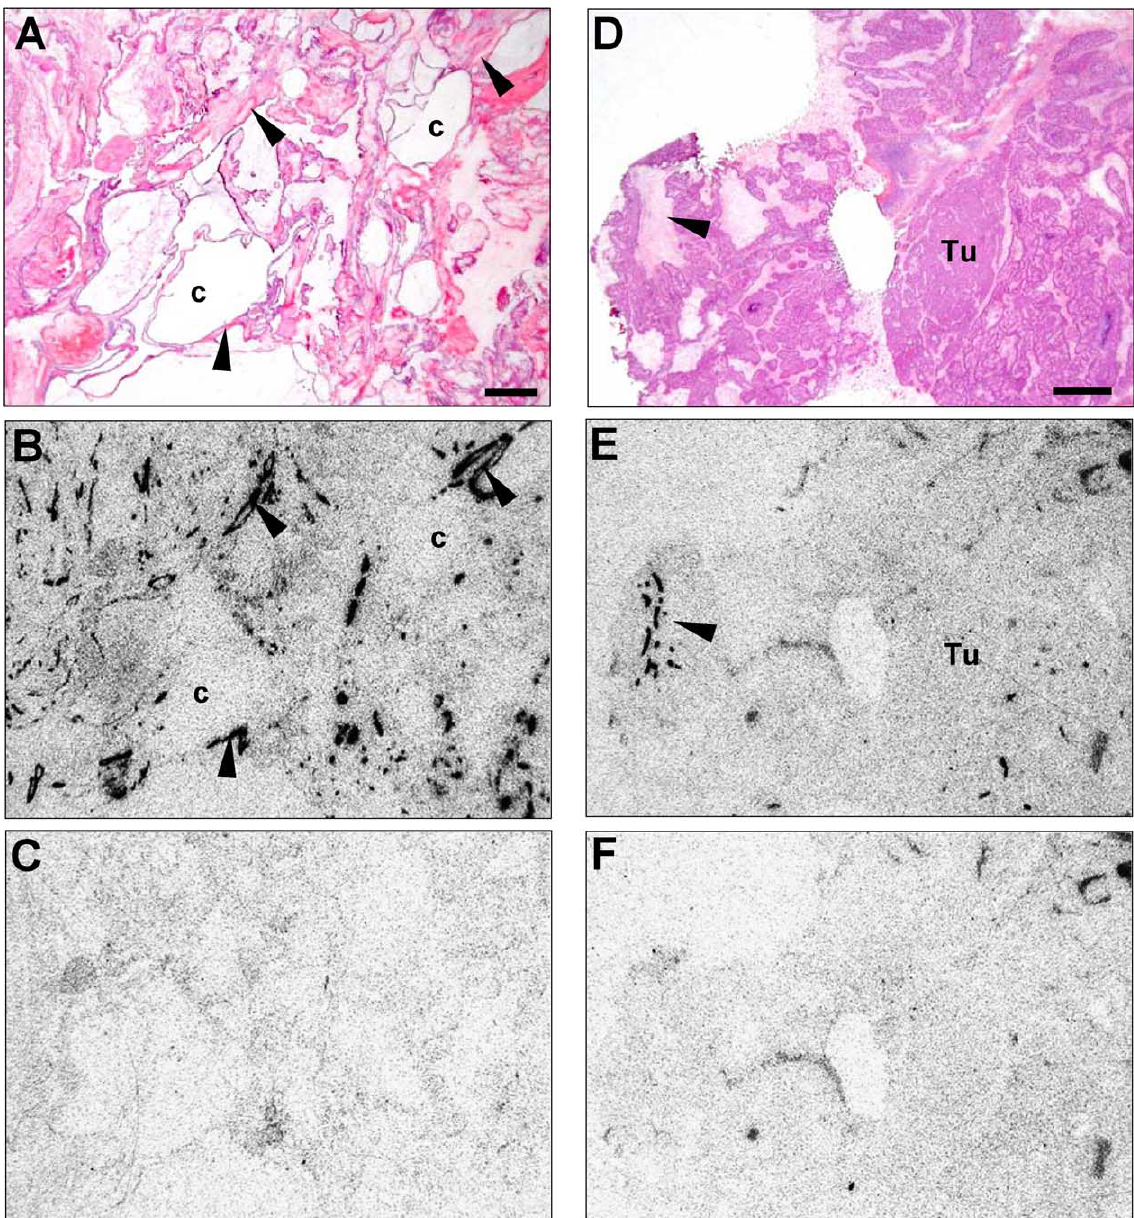
Fig. 1. Overview of two ovarian tumors with GRP-receptor positive blood vessels. A, D: H&E stained sections; bars = 1 mm. A: mucinous borderline tumor with epithelial lined cysts (c) in a tumor stroma with numerous blood vessels (three indicated by arrowheads); D: serous adeno- carcinoma with solid growth of the neoplastic cells (Tu). Arrowhead indicating a circumscribed area of vascularized tumor stroma surrounded by neoplastic tissue. B, E: autoradiograms showing total binding of 125 I-[Tyr 4 ]-bombesin. The distribution of the strongly labeled tumoral vessels is diffuse in B (three vessels indicated by arrowheads) and focal in E (arrowhead), respectively. The neoplastic cells lining the cysts (c) in B and growing solid (Tu) in E, respectively, are not labeled. C, F: control sections showing non-specific